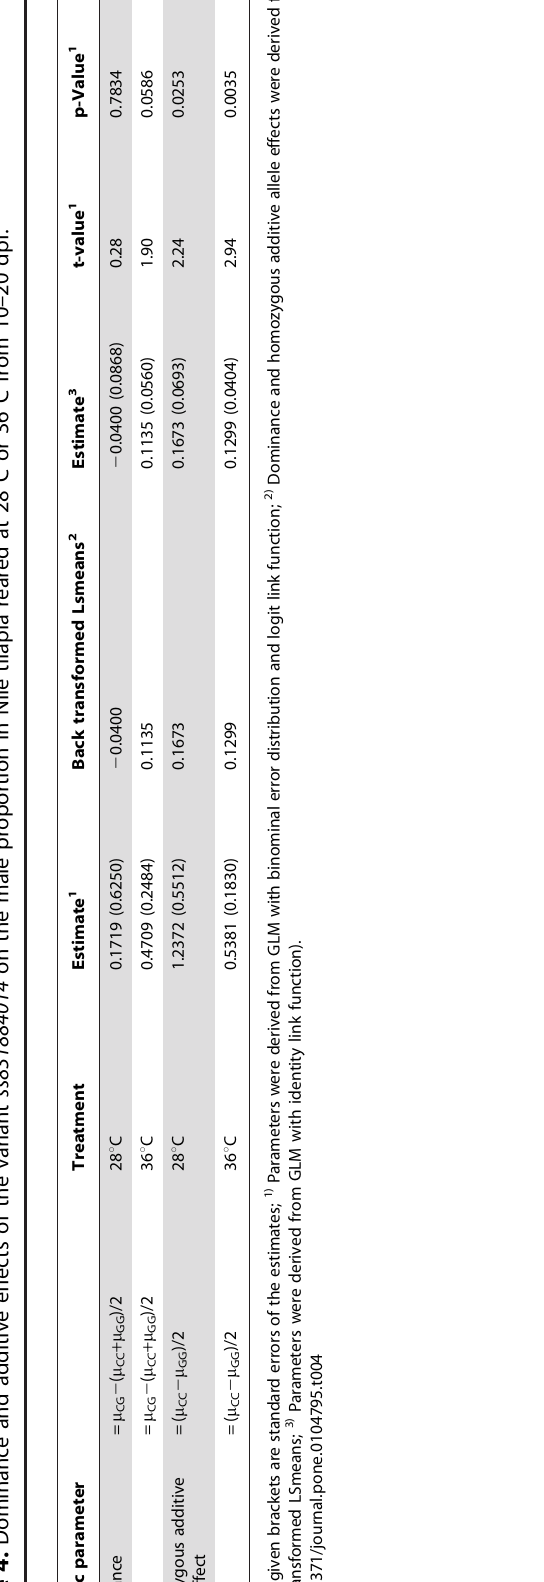
S1, Melt curve analysis output from the Lightcycler 480 system for genotypes at amh variant ss831884014. Different genotypes are illustrated using different colours: C/C = green curve, C/G and G/C= blue curve, and G/G= red curve. Homozygeous C/C individuals show a fluorescence peak between 483 and 610 nm wave length at 58 u C, whereas homozygeous G/G individuals showed one at 64 u C, and heterozygous fish showed two peaks. Table S1, Pedigree and sex ratios of the genetically female population reared at control (28 u C) and elevated temperature (36 u C) from 10 to 20 dpf. Table S2, Forward and reverse primers tailed with a universal M13 forward or reverse primer for bidirectional sequencing the amh gene in Nile tilapia. Table S3, Fret-primer for allelic variant 1690582 in the Nile tilapia amh gene, anchor and sensor probe sequences and positions on scaffold GL831234.1. Table S4, R 2 -measure of linkage disequilibrium between four segregating allelic variants in the amh gene of Nile Tilapia. The estimates were derived from a sample 93 tempera- ture-treated Nile tilapia individuals. Table S5, Raw data for the genetically female study population reared at control (28 u C) and elevated temperature (36 u C) from 10 to 20 dpf. Table S6, Genotypes of four segregating SNPs in the amh gene of 93 individuals derived from three Nile tilapia families.